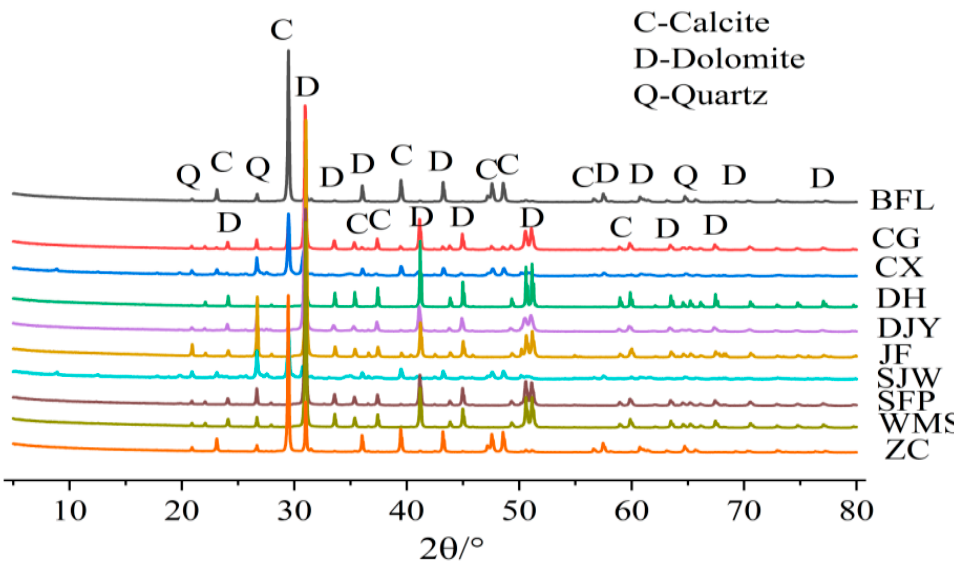
Figure 1. The XRD pattern of different rocks.